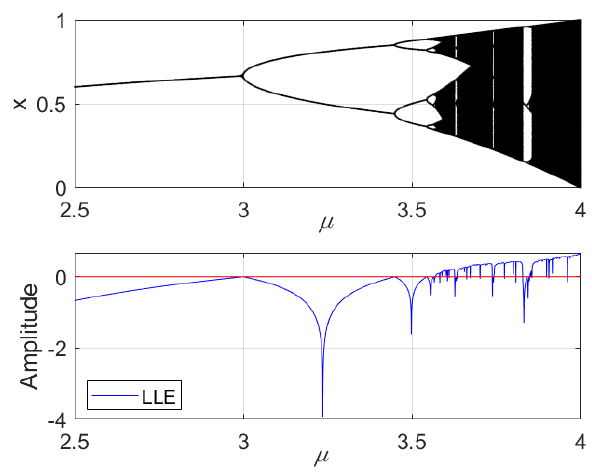
Figure 10. The logistic map and its LLE.